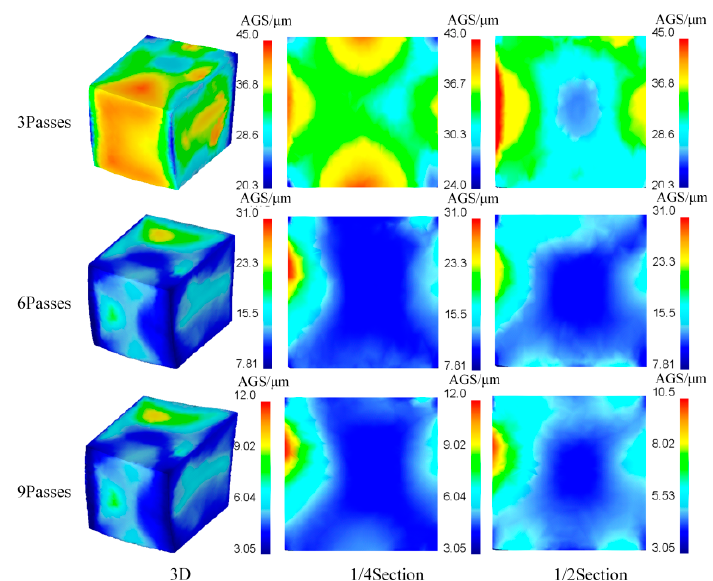
Figure 14. Forging from three to nine passes for dynamic recrystallization volume fraction cloud image at 900 °C.